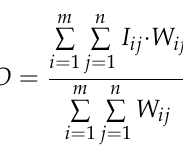
Figure 6. ( a ) The selectivity of textural features in the pooling process; ( b ) The selectivity of color features in the pooling process. No matter what traditional pooling method is used, all feature maps use a single sampling way, which will inevitably cause loss of feature information and affect perfor- mance of CNN. An adaptive pooling method was proposed in this paper, and its pooling process was shown in Figure 7. For input feature maps, firstly, the pooling kernels were deployed for each feature map; each kernel was independent of each other. Then, initial values were set randomly between 0 and 1 for each kernel. Finally, convolutional results were calculated between the feature maps and the pooling kernels through Equation (8).